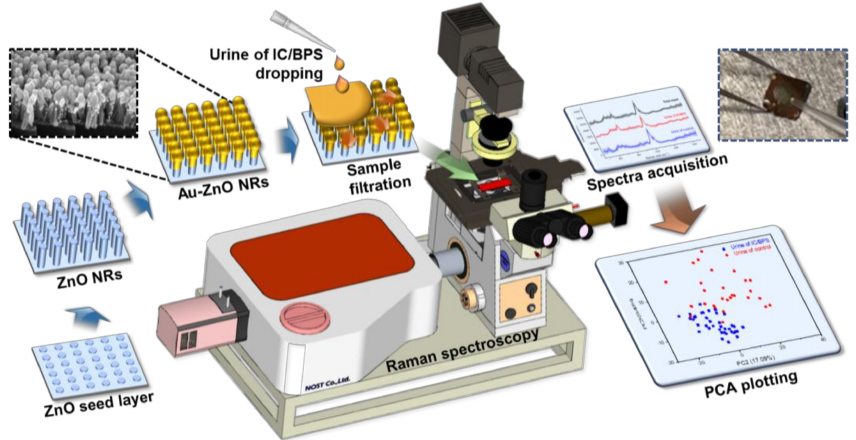
Figure 1. Schematic showing the production process, measurement, and analysis process of the ZnO nanorod-based SERS sensing